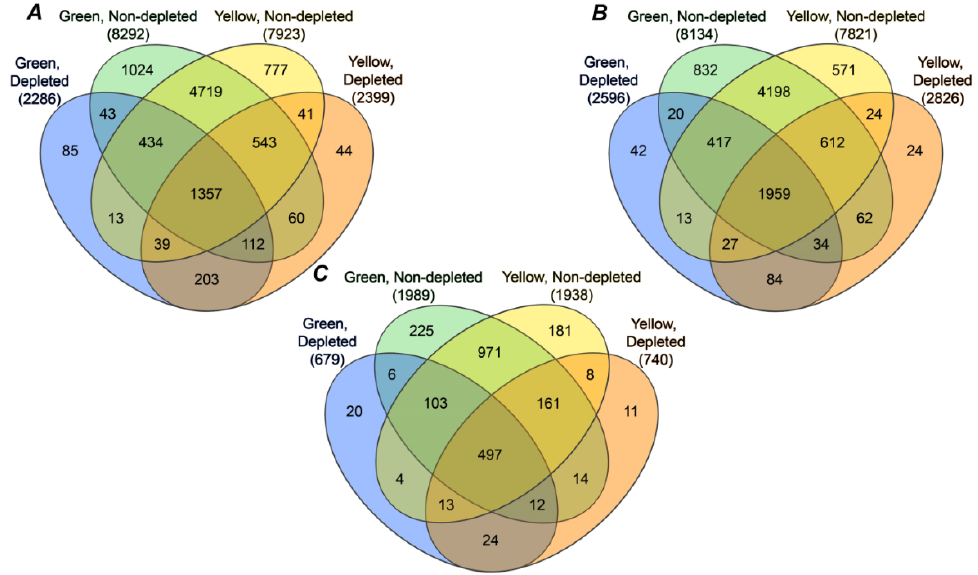
Figure 4. The numbers of tryptic ( A ) peptides, ( B ) proteins, and ( C ) protein groups, identified in yellow-colored (cultivar Millennium) and green-colored (cultivar Gloriosa) seeds with and without depletion of highly abundant proteins with protamine sulfate.